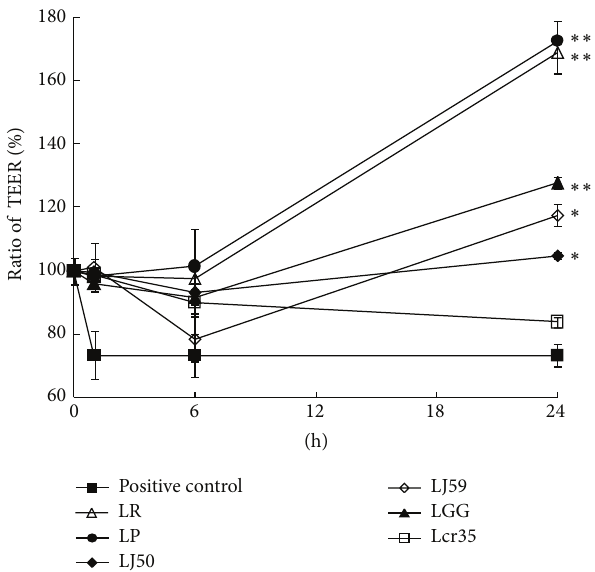
Figure 1: Effect of Lactobacilli on Caco-2 monolayer resistance. TEER ratio of inflamed Caco-2 monolayers exposed to positive control medium ( ◼ ), LGG ( 󳵳 ), Lcr35 ( ◻ ), LR ( △ ), LP ( ∙ ), LJ50 ( X ), and LJ59 ( ⬦ ) into the apical compartment. TEER ( Ω × cm 2 ) was expressed as thepercentage at time 3hr in relation to the initial value for each treatment. ∗ 𝑃 < 0.05 ; ∗∗ 𝑃 < 0.005